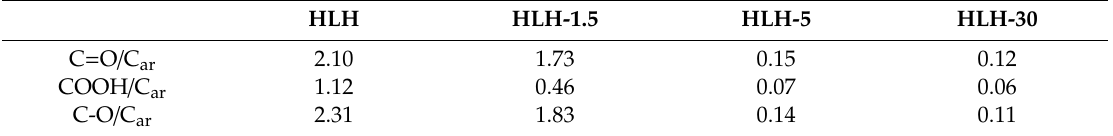
Table 2. Quantitative result of treated samples under different microwave radiation times.